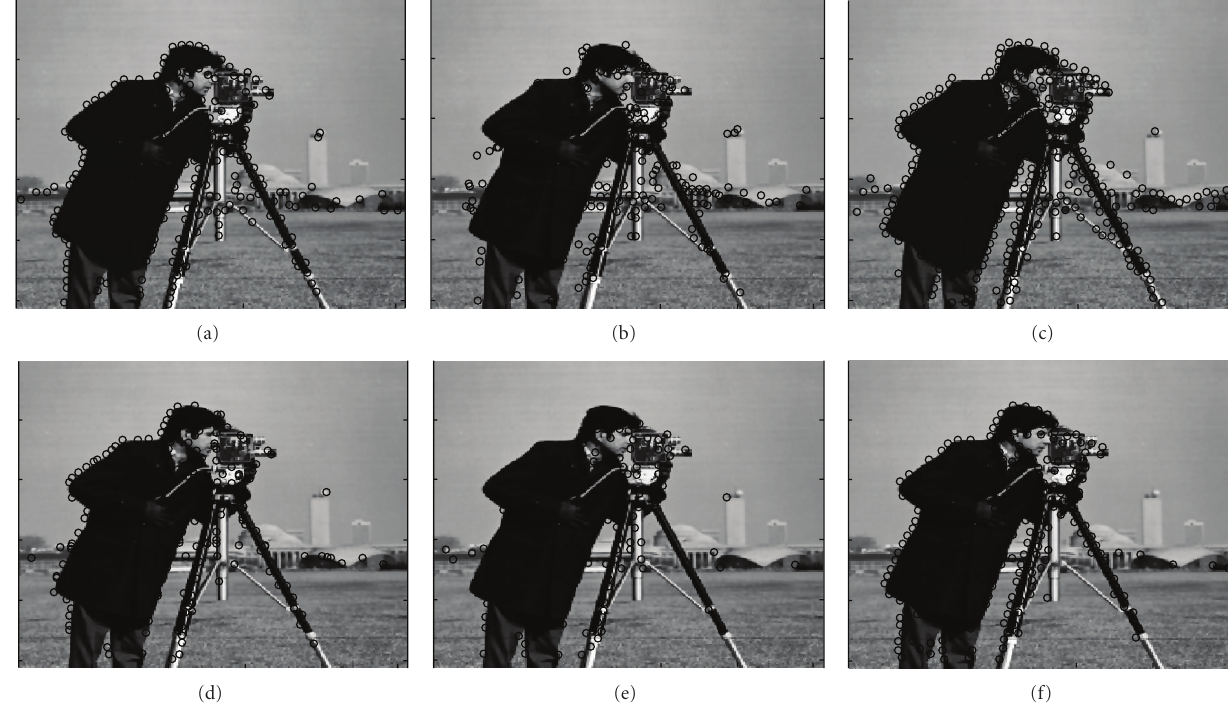
Figure 4: Feature points detected by (a) Harris’ method, (b) Lowe’s method, (c) Tomasi’s method, (d) Loupias’ technique, (e) Yeh’s algorithm, and (f) proposed technique.